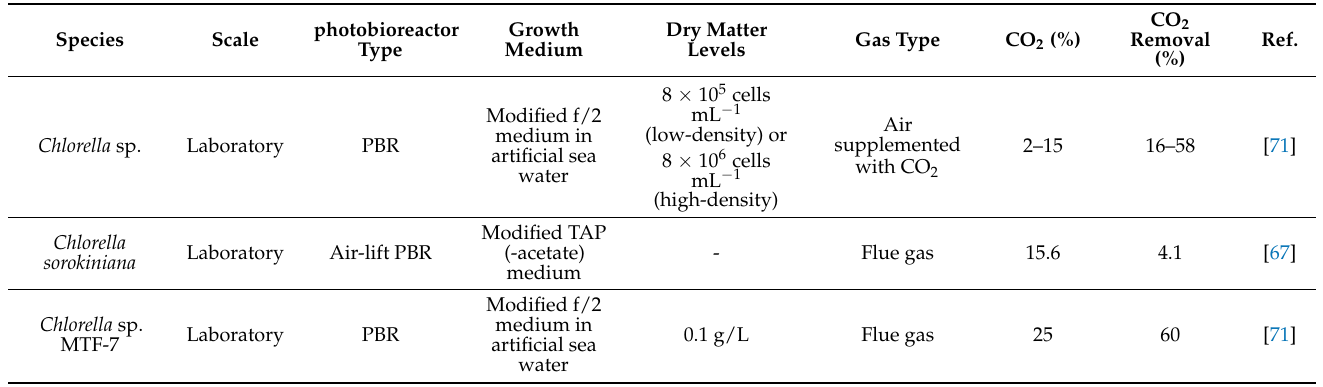
Table 2. Literature data on the efficiency of microalgae-mediated CO 2